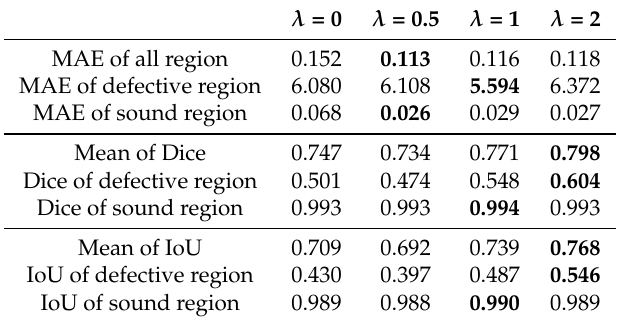
Table 5. Results of the proposed method with different values of λ